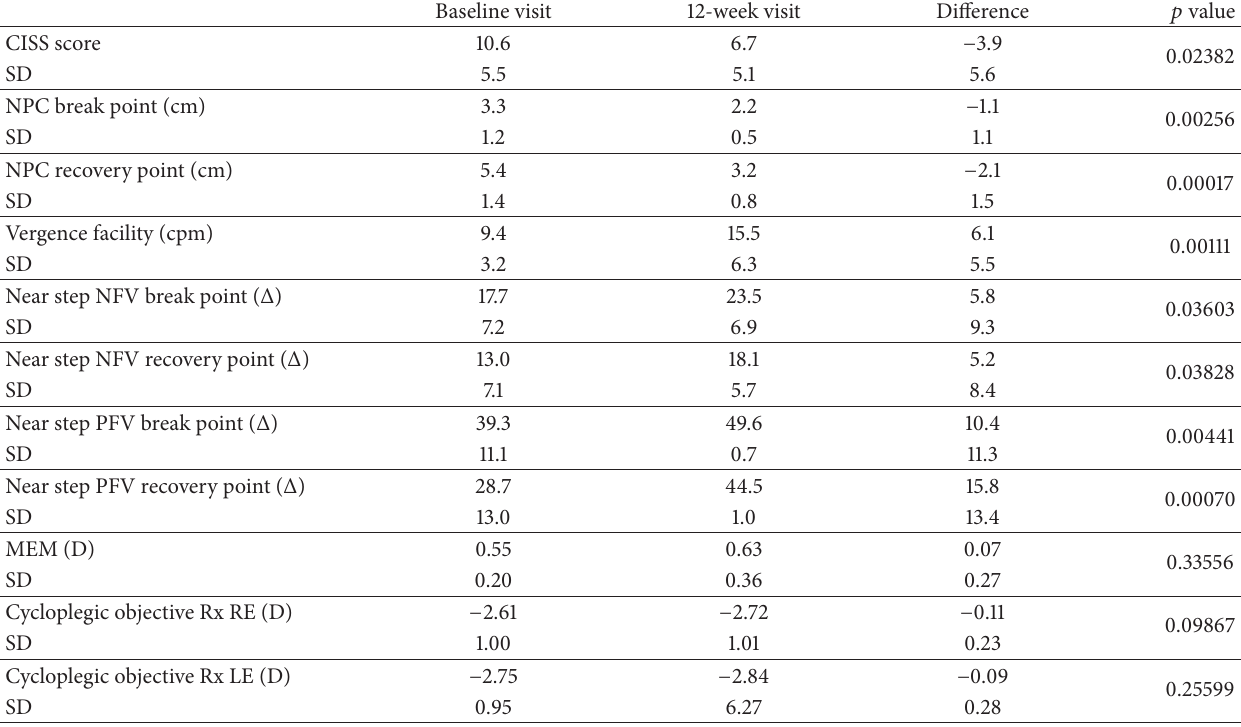
Table 5: Effect of vision therapy on other